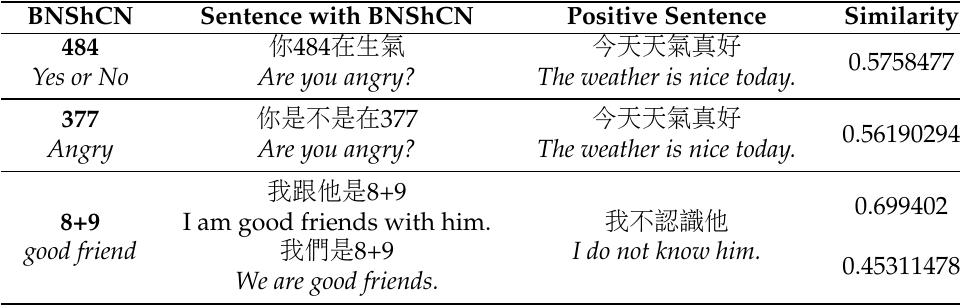
Table 7. BNShCNs and negative